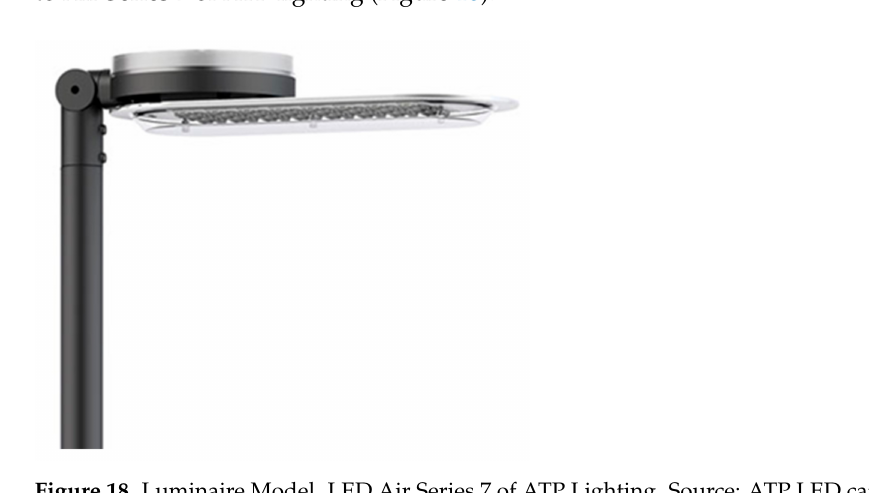
Figure 18. Luminaire Model. LED Air Series 7 of ATP Lighting. Source: ATP LED catalog lighting.